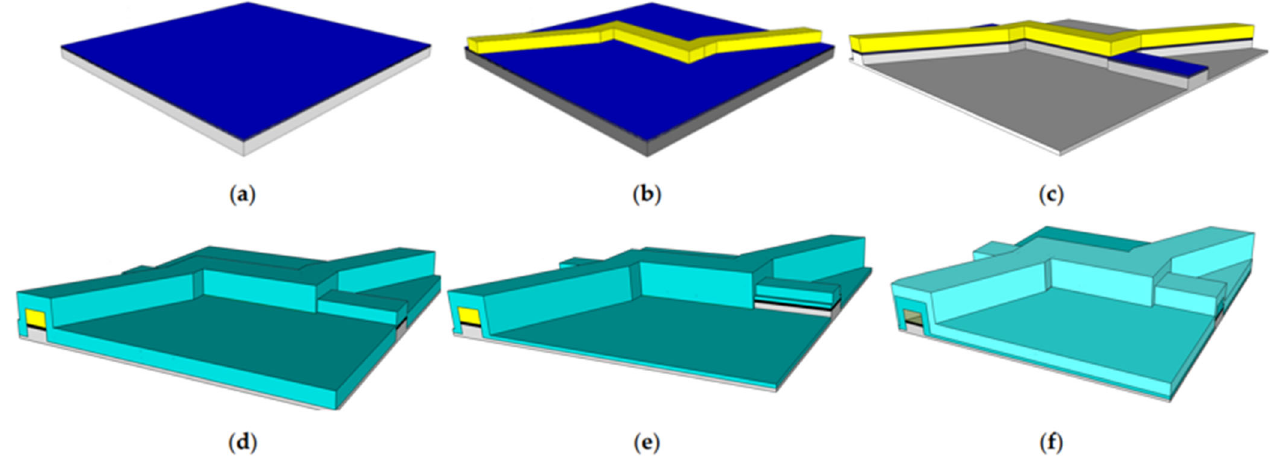
Figure 2. Outline of a fabrication process for a flow-through optofluidic biosensor: ( a ) the substrate; ( b ) sacrificial layer for the hollow channel; ( c ) collection waveguides etched in; ( d ) oxide layer deposition; ( e ) collection waveguides etched; ( f ) cladding layer deposition and sacrificial layer etch.